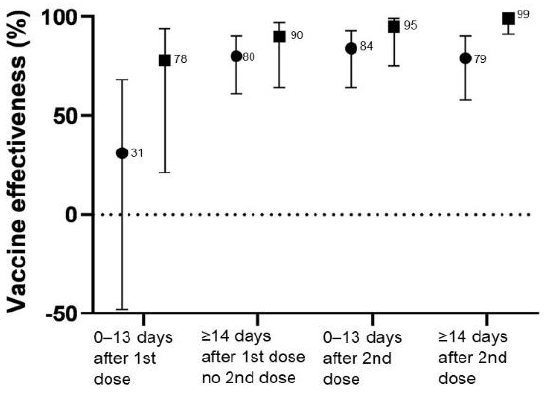
Figure 1. Vaccine effectiveness against any COVID − 19 infection ( • ) and COVID − 19related hospital- ization ( ■ ).